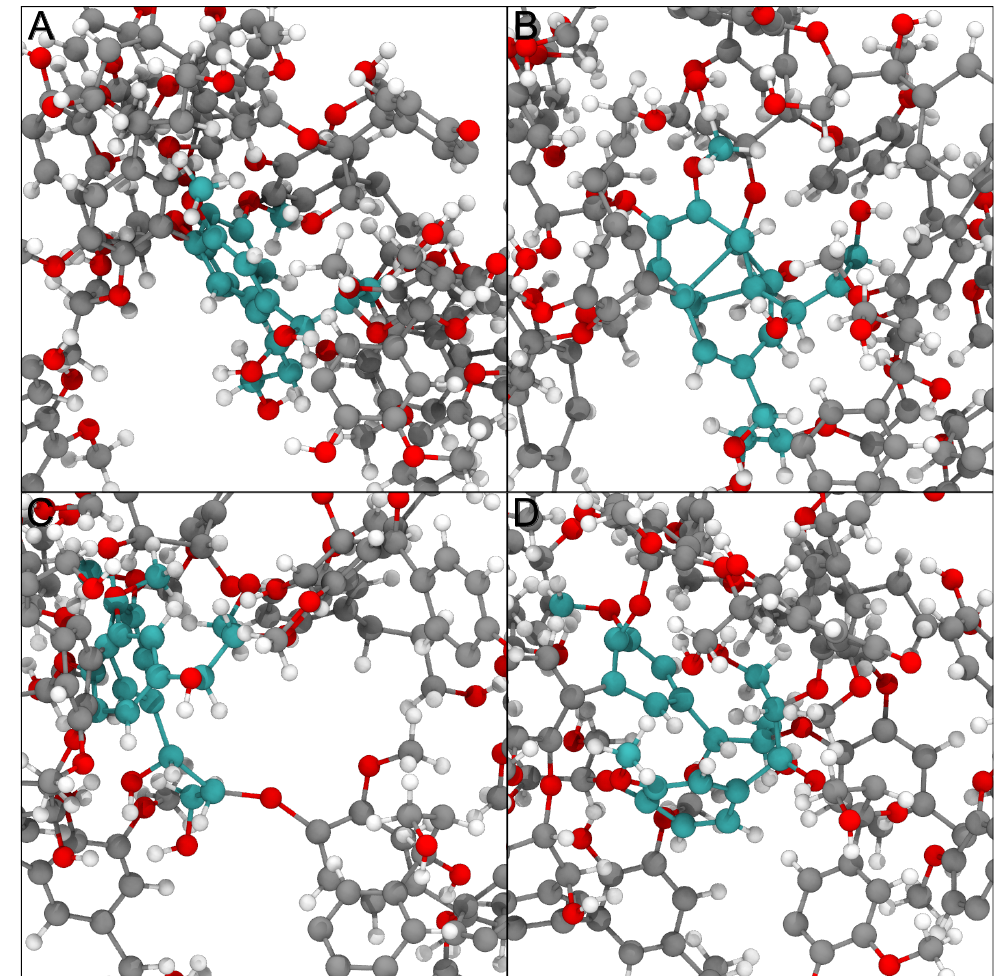
Figure 3. Example of how physically impossible structures are ameliorated by the LBE process. Different panels here represent snapshots taken along the LBE process for a single unphysical geometry in the lignin testcase. The original structure shown in panel ( A ) has two residues with cyan carbon atoms whose aromatic rings that are in close physical proximity based on the initial construction process. After minimization, these rings pierce one another, as shown in panel ( B ). By applying multiple biasing approaches, the rings are moved substantially, resulting in panel ( C ). After further minimization, the rest of the molecular environment moves the two residues of interest close to their original positions, but critically these residues are no longer overlapping one another. The structural representation in panel ( D ) is thus ready for further